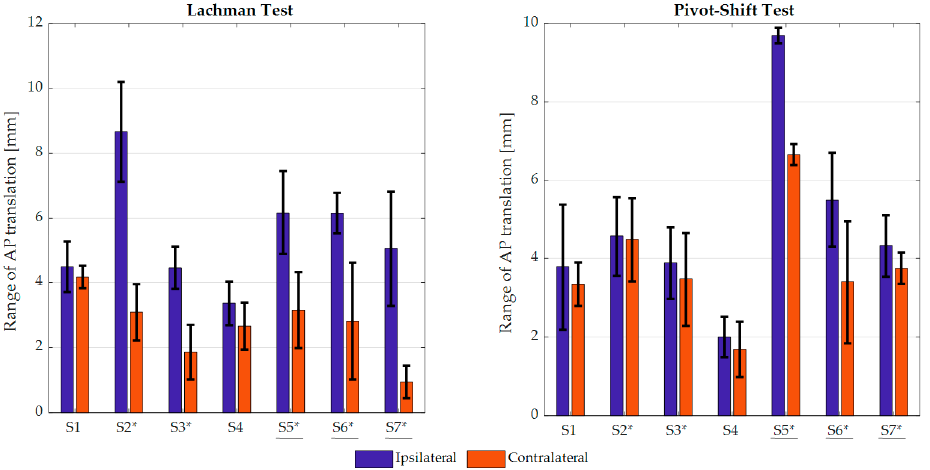
Figure 3. Range of anterior–posterior translation values (mean ± standard deviation) in the ipsilateral (injured) and contralateral (non-injured) legs of seven anterior cruciate ligament (ACL)-deficient subjects during Lachman and Pivot–Shift tests. Note that the vertical axes do not have the same range of values. The underlined subjects were under anesthesia. The star * indicates significant differences ( p < 0.05).